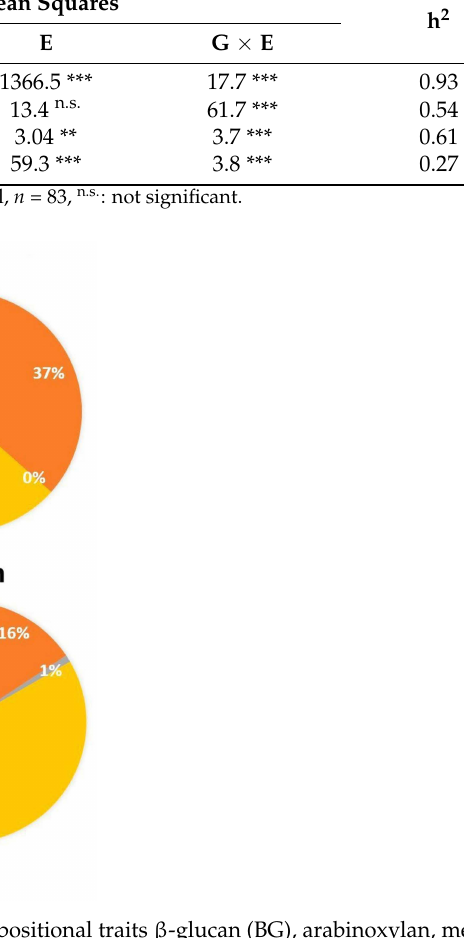
Table 2. The effect of genotype (G), environment (E), and their interaction (G × E) on the composi- tional quality traits of the Ae. biuncialis genotypes as determined by linear mixed model analysis. Mean Squares